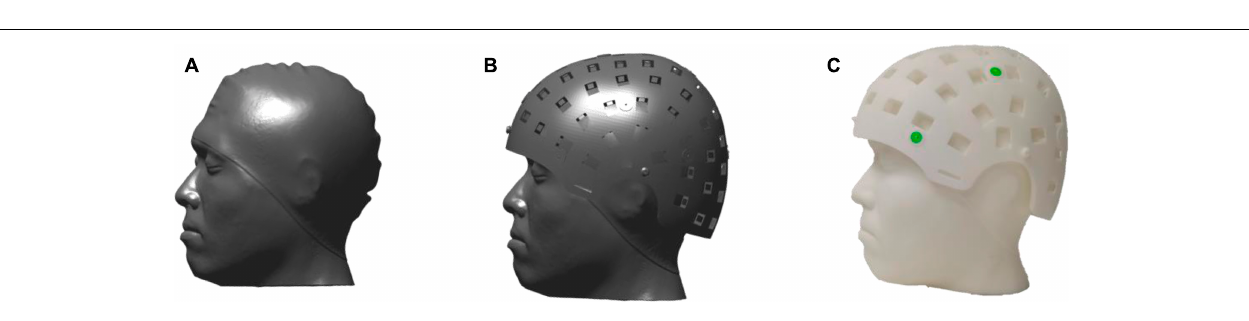
FIGURE 5 | (A) The head of the subject scanned by the laser scanner. (B) Put the designed helmet on the scanning head. (C) The reference phantom made 3D